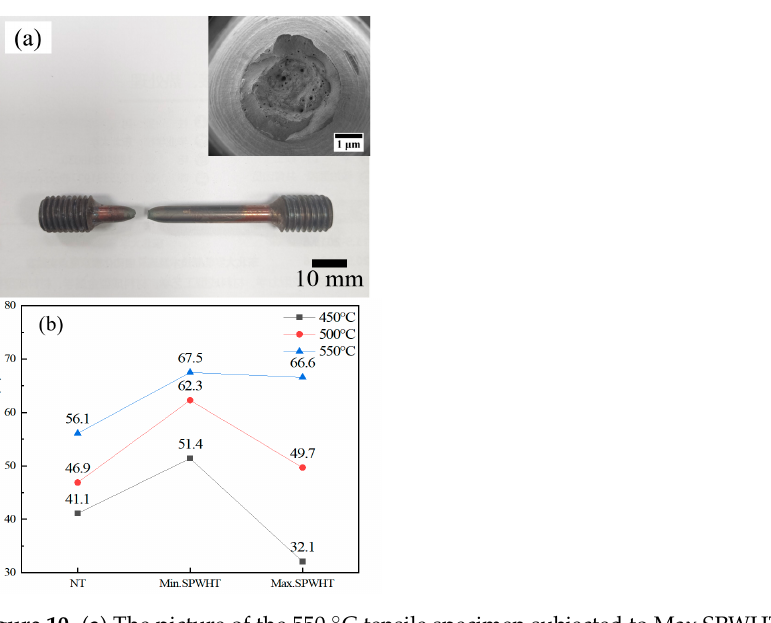
Figure 10. ( a ) The picture of the 550 °C tensile specimen subjected to Max.SPWHT; ( b ) the reduction rate of the area of the specimen after the high-temperature tension test.